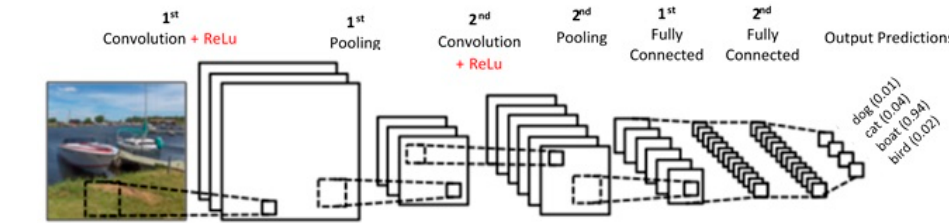
Figure 2. A simple CNN architecture.